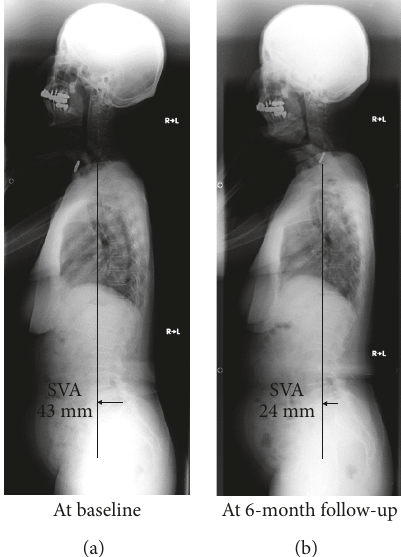
Figure2:A72-year-oldwomanwith“locomotivesyndromerisklevel2”fromlumbarspinalcanalstenosis.Standingwhole-spineradiographs showed the sagittal vertical axis (SVA) of 43 mm with decreased thoracic kyphosis (a). After our 6-month “locomotion training” outpatient rehabilitation program, she showed the improvement to “locomotive syndrome risk level 1” with the improved SVA up to 24 mm ( < 40mm, normal range) and increased thoracic kyphosis in radiographs